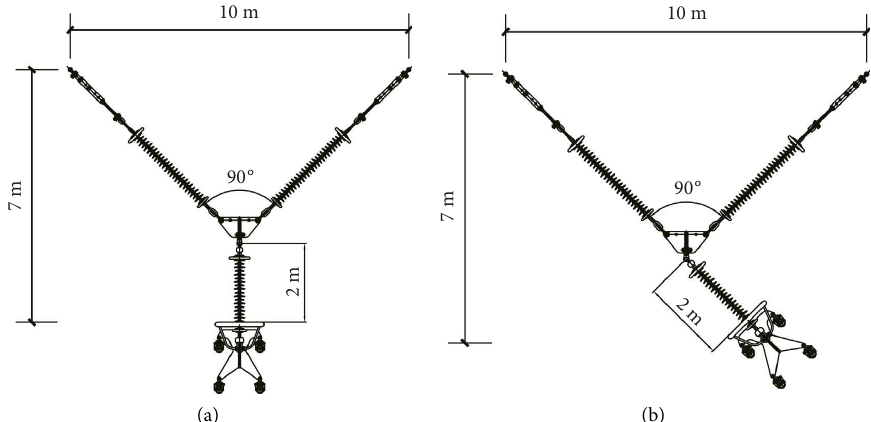
Figure 15: (a) Te dimension of the Y -type insulator string. (b) Te windage yaw model of the Y -type insulator string.